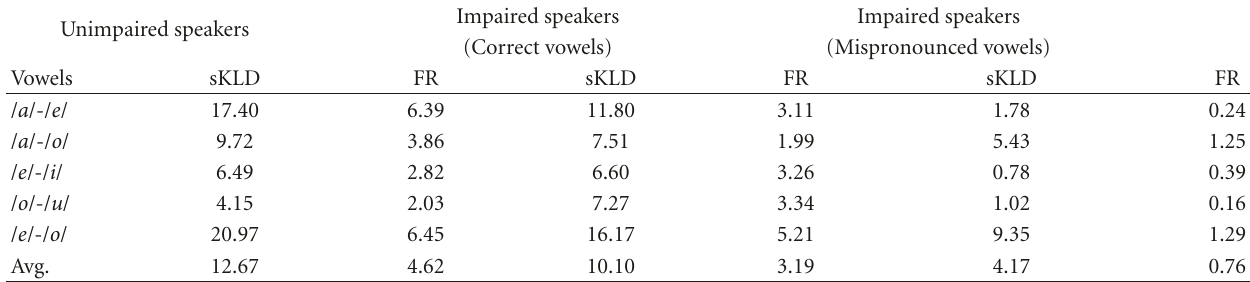
Table 13: sKLD and FR for the most confusable pairs of vowels in the Spanish formants (Avg is the weighted average over the number of appearances of every vowel).